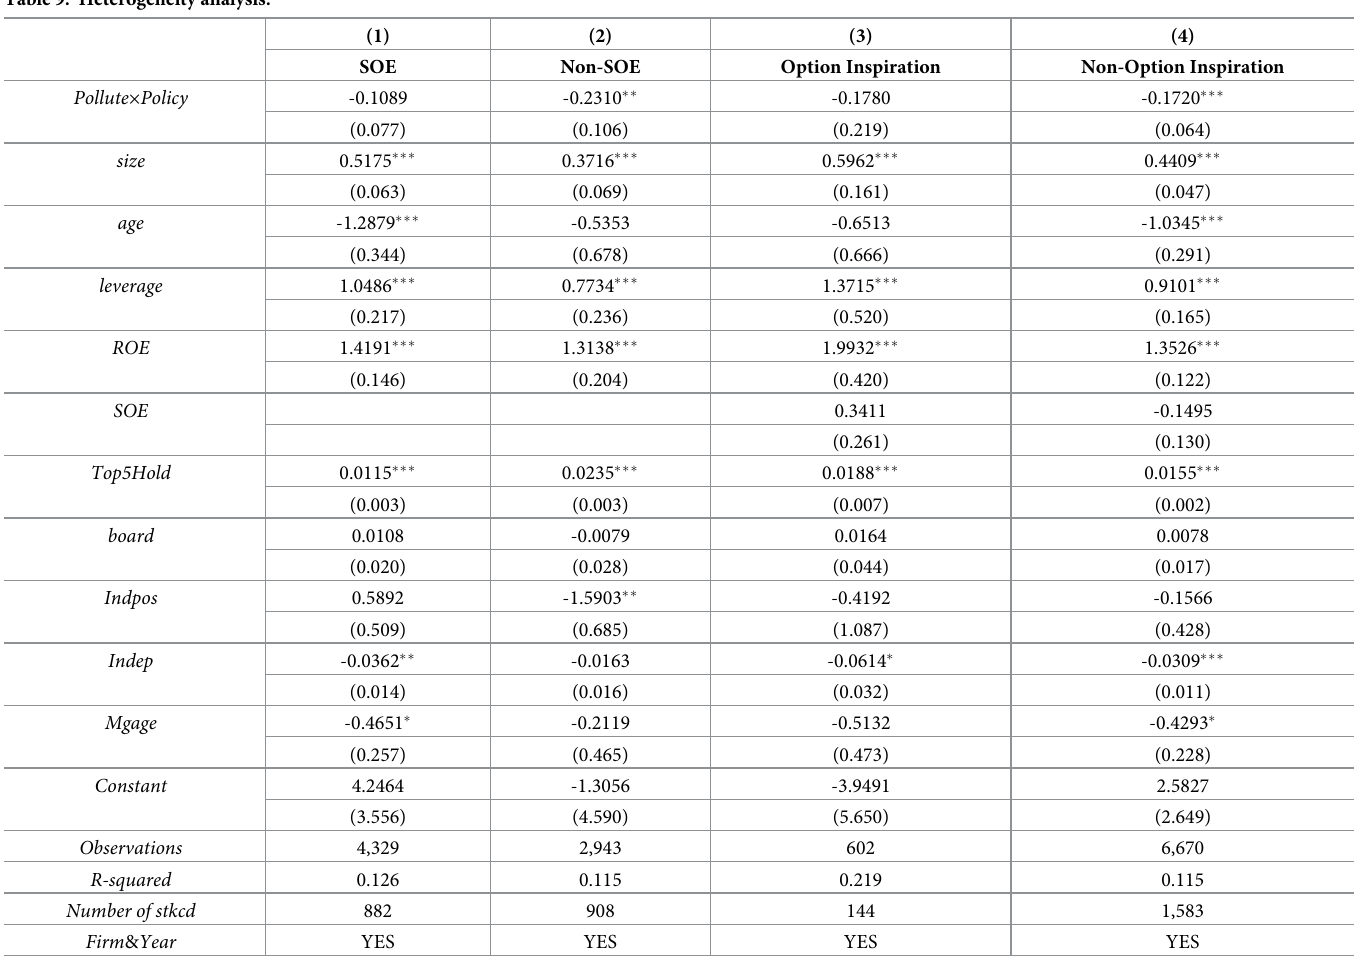
Table 9. Heterogeneity